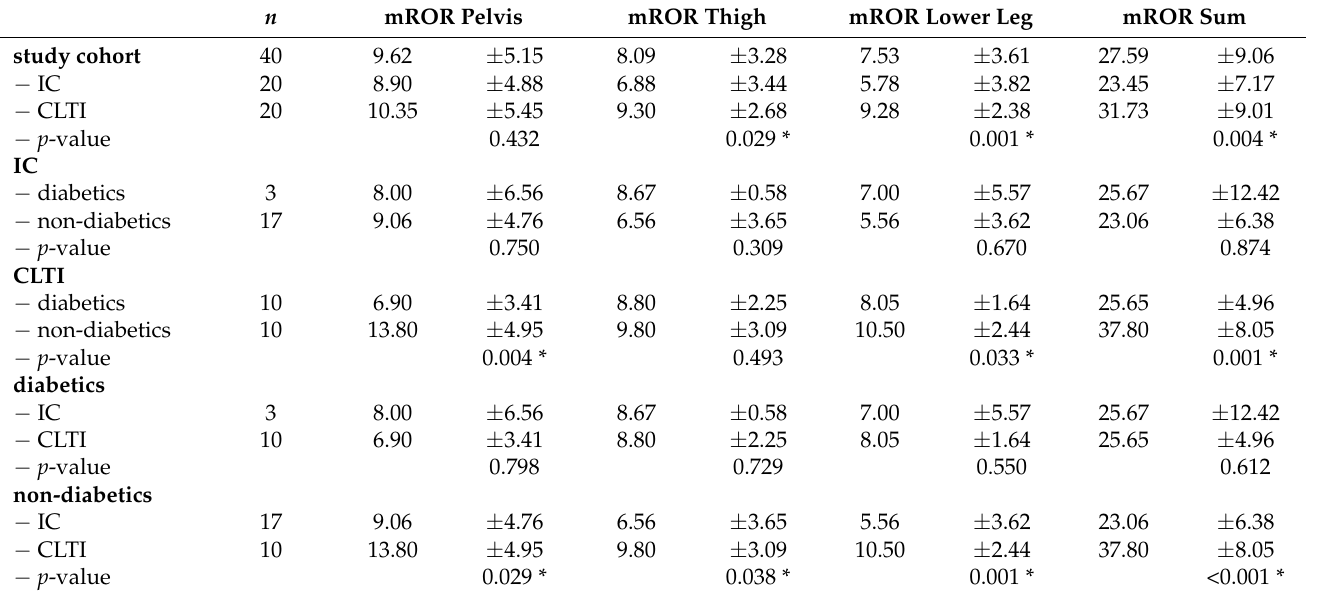
Table 2. Sum scores and subgroup analyses of the main arterial levels (pelvis including the infrarenal aorta, thigh, and lower leg) of the modified runoff resistance (mROR) anatomical scoring system acquired by computed tomography angiography; comparing groups of patients with intermittent claudication (IC) or chronic limb-threatening ischemia (CLTI) and diabetic or non-diabetic patients. ROR values are given as mean ± standard deviation. An asterisk * marks a p -value < 0.05.